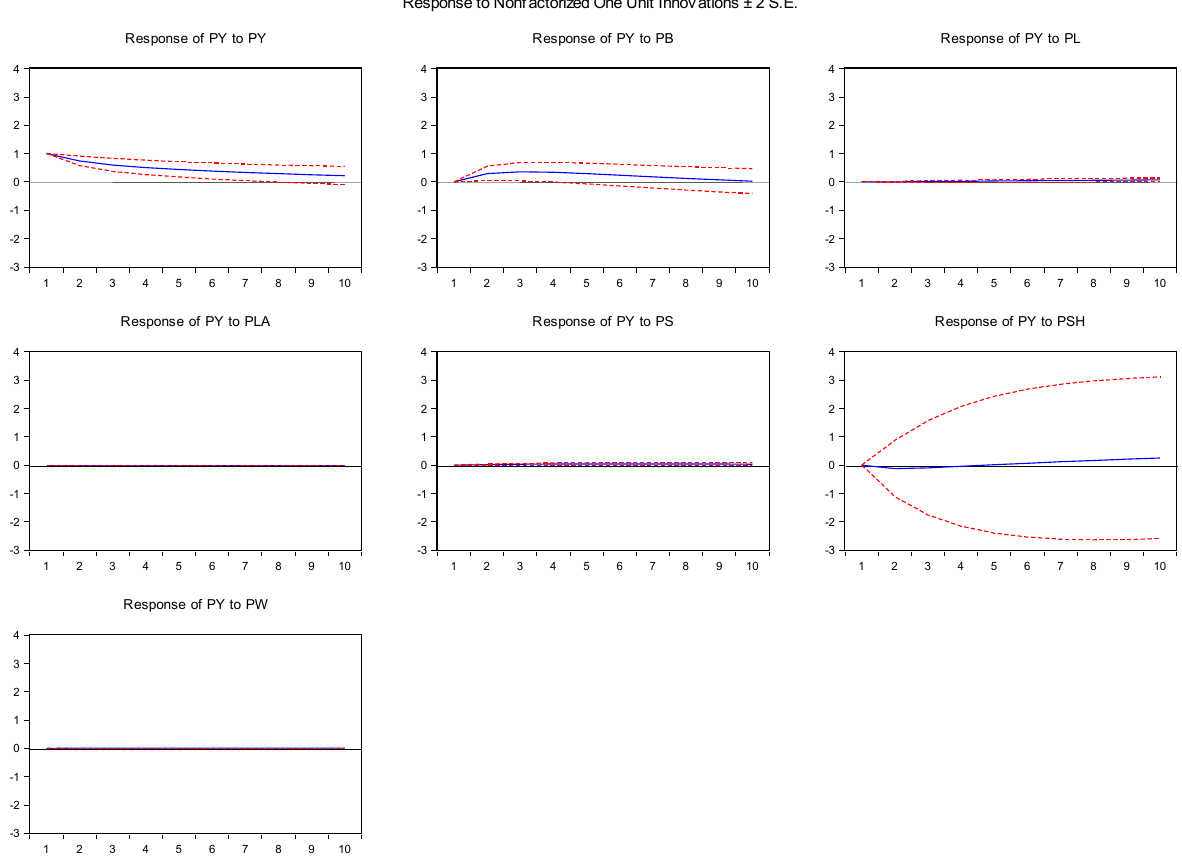
Figure 1. The dynamic response of cotton price to shocks to the descriptive variables of the model